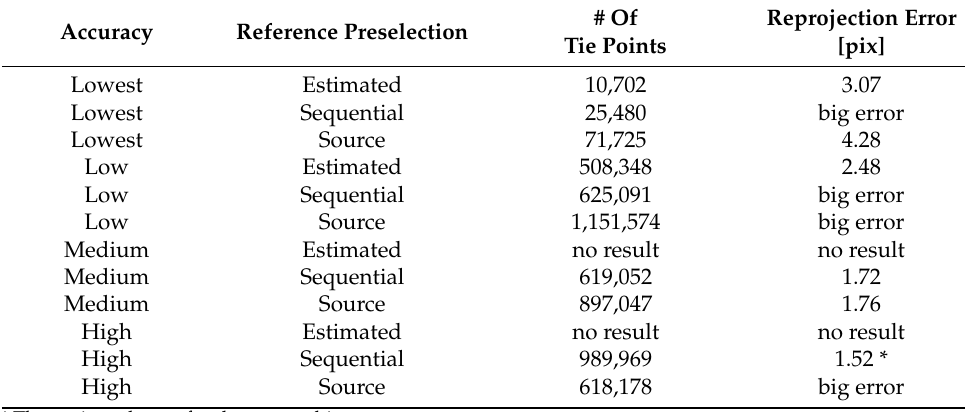
Table 3. DJI Matrice 300 RTK wide + zoom photos alignment